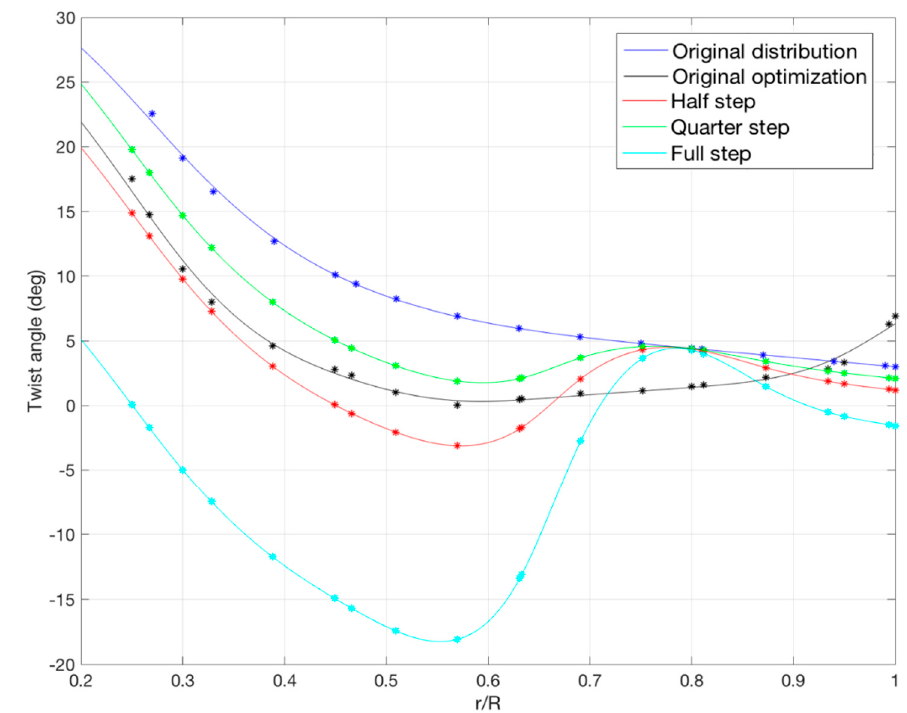
Figure 24. Twist angle distribution for different blade configurations.